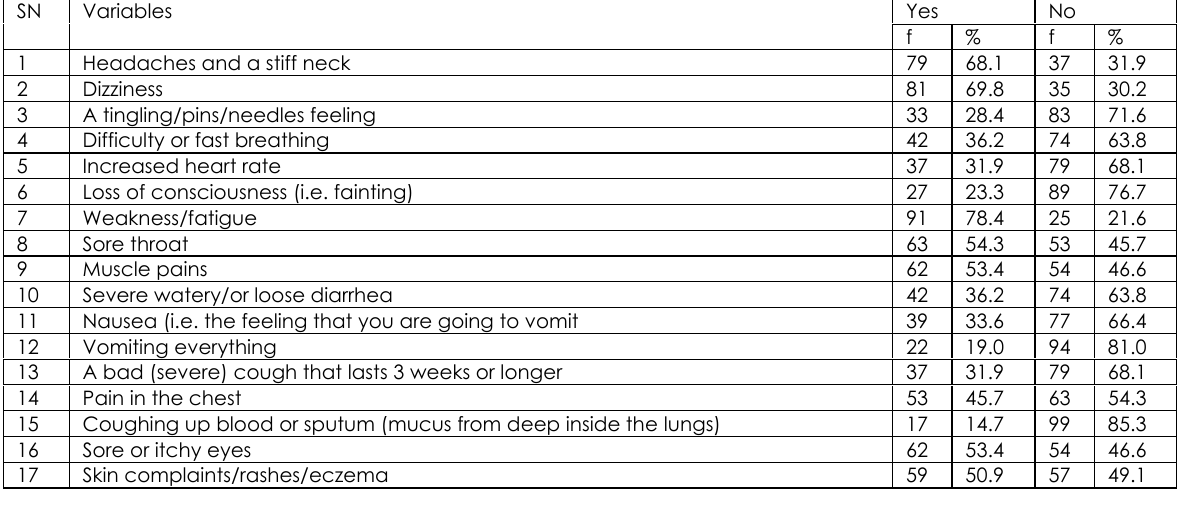
Table 1. Symptoms of illness experienced by the respondents in the indoor environment.